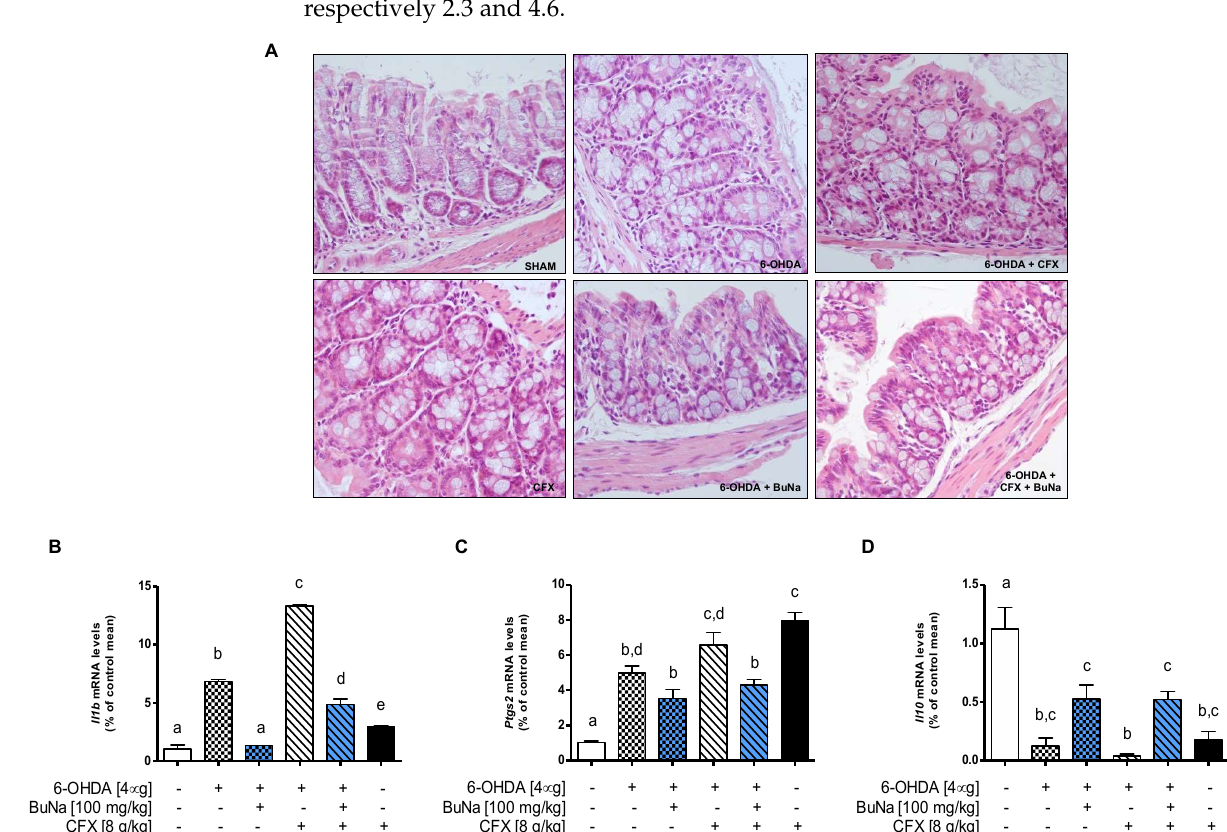
Figure 4. Histological analysis of distal colon sections of mice. ( A ) Haematoxylin & eosin staining (magnification × 400). ( B – D ) Transcriptional levels of Il1b , Ptgs2 , and Il10 were evaluated in colonic tissues. All data are shown as mean ± S.E.M ( n = 4–6). Labeled means without a common letter differ, p < 0.05.